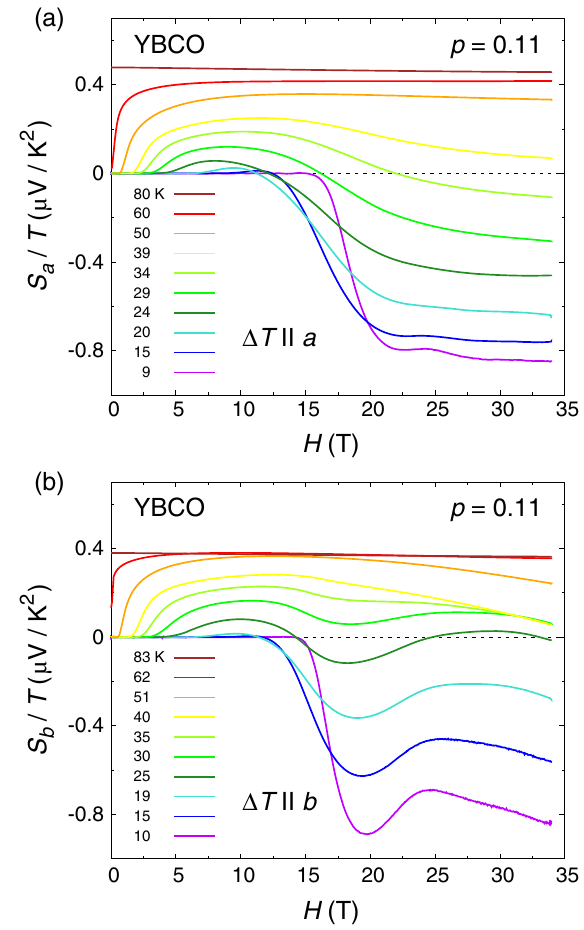
FIG. 1. Seebeck coefficient of YBCO at p ¼ 0 . 11 , for a heat current along the a axis (a) and b axis (b) of the orthorhombic crystal structure, plotted as S=T versus magnetic field H , at various temperatures, as indicated. The negative value of S=T at low temperature and high field is the signature of Fermi-surface reconstruction. In the isotherms of S b =T versus H (b), a clear dip develops below T ≃ 40 K, at H ≃ 18